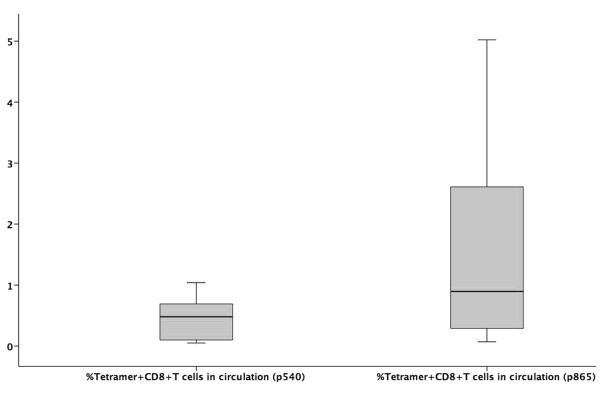
Box plot comparing tetramer responses to class I hTERT peptide. Class I peptides of hTERT (p540 and p865) were compared for the efficacy of the tetramer response. hTERT-p865 generated a higher tetramer response compared with hTERT-p540, though this was not statistically significant (p = 0.06. Wilcoxon signed rank test). Values are represented as median(bar), interquartile range (box) and range (whiskers).